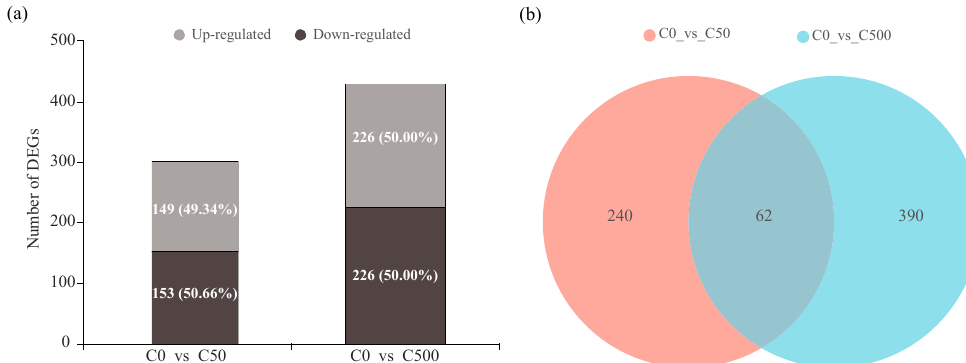
Figure 4. ( a ) Number of up- and down-regulated DEGs in various Cd concentrations. ( b ) Venn diagram of all DEGs. C0: group treated with 0 mg · kg –1 cadmium. C50: group treated with 50 mg · kg –1 cadmium. C500: group treated with 500 mg · kg –1 cadmium.